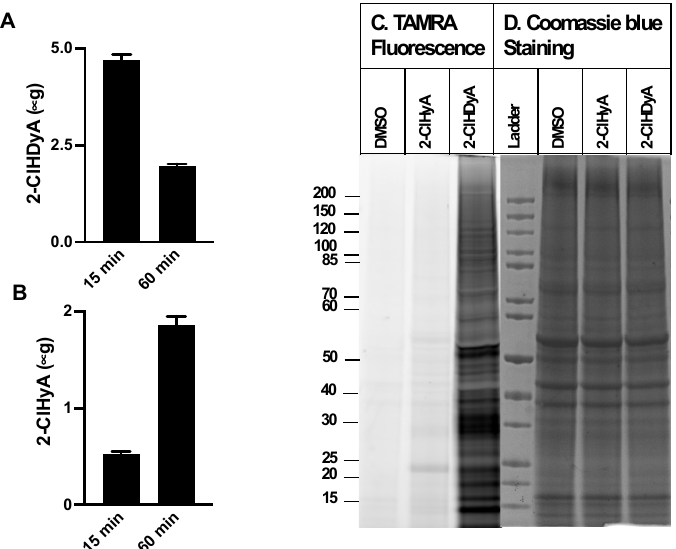
Figure 4. 2-ClHDyA metabolism and protein modification in HLMVECs. HLMVECs were treated with 10 μ M 2-ClHDyA for indicated time intervals. At the end of each time point, cellular and media lipids were extracted together, and 2-ClHDyA ( A ) and 2-ClHyA ( B ) were quantitated as described in “Materials and Methods”. Values are average + SEM for n = 4 in both A and B; ( C ) HLMVECs were treated with either DMSO, 10 μ M 2-ClHyA, or 10 μ M 2-ClHDyA for 1 h at 37 °C. Proteins modified by these ω -alkyne chlorolipids were clicked with TAMRA-azide and were visualized after gel electrophoresis; ( D ) Coomassie blue staining of gel protein loads used for TAMRA fluorescence